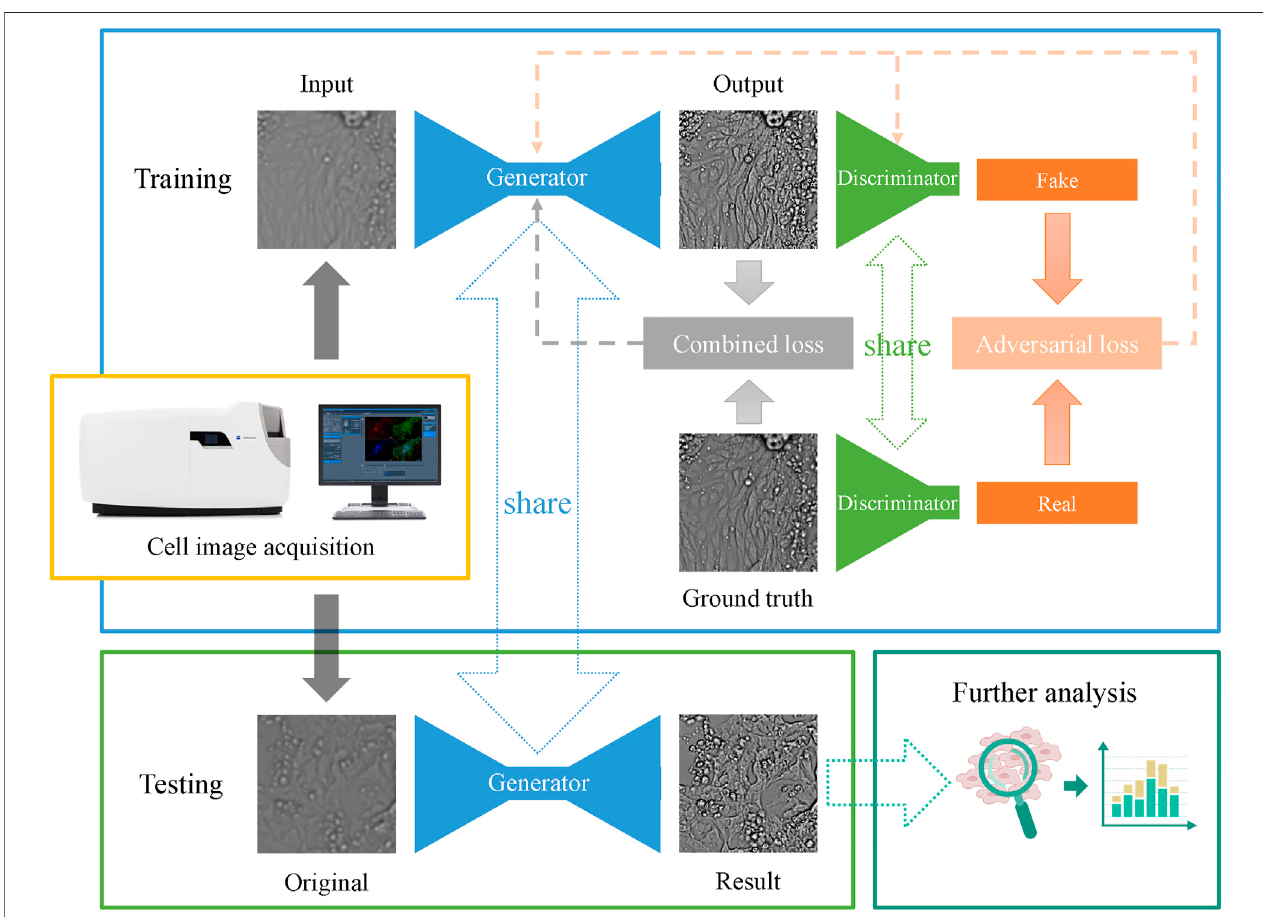
FIGURE 4 | Network architecture and the main pipeline of the CIEGAN. The training process of the model is shown in the blue box, and the testing process of the modelisshowninthegreenboxinthelower-leftcorner,wherethegeneratorisshared.Oncethemodelistrained,itcanpredictasharpimagefromtheoriginalimperfect cell